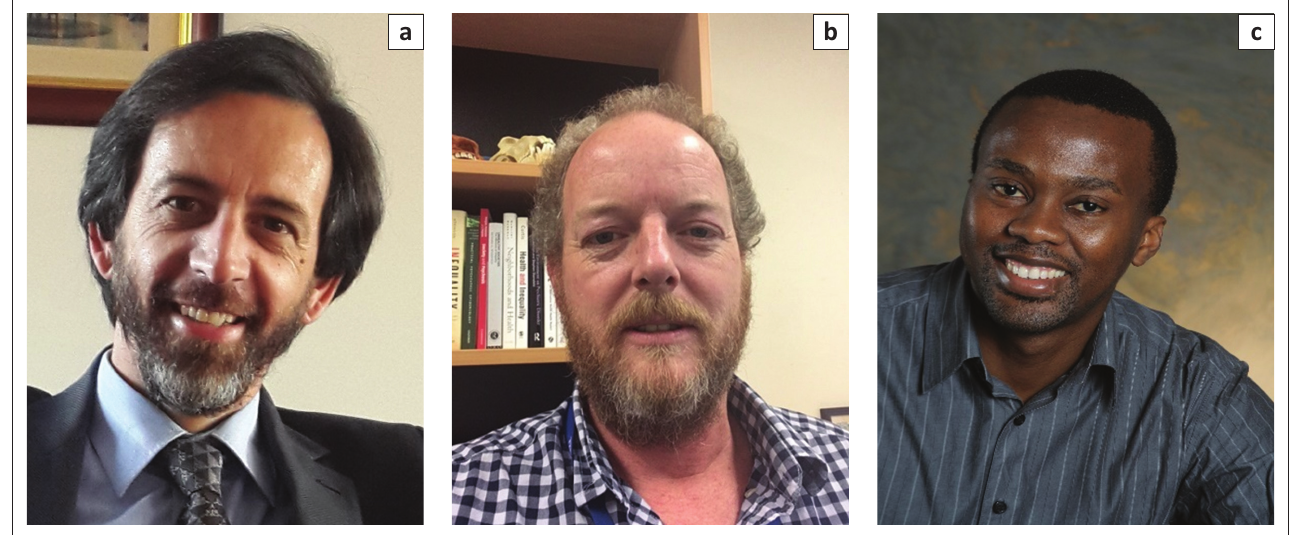
FIGURE 1: (a) Prof. Werdie van Staden Outgoing Editor-in-Chief (b) Prof. Jonathan Burns New Editor-in-Chief (c) Prof. Bonga Chiliza New Deputy